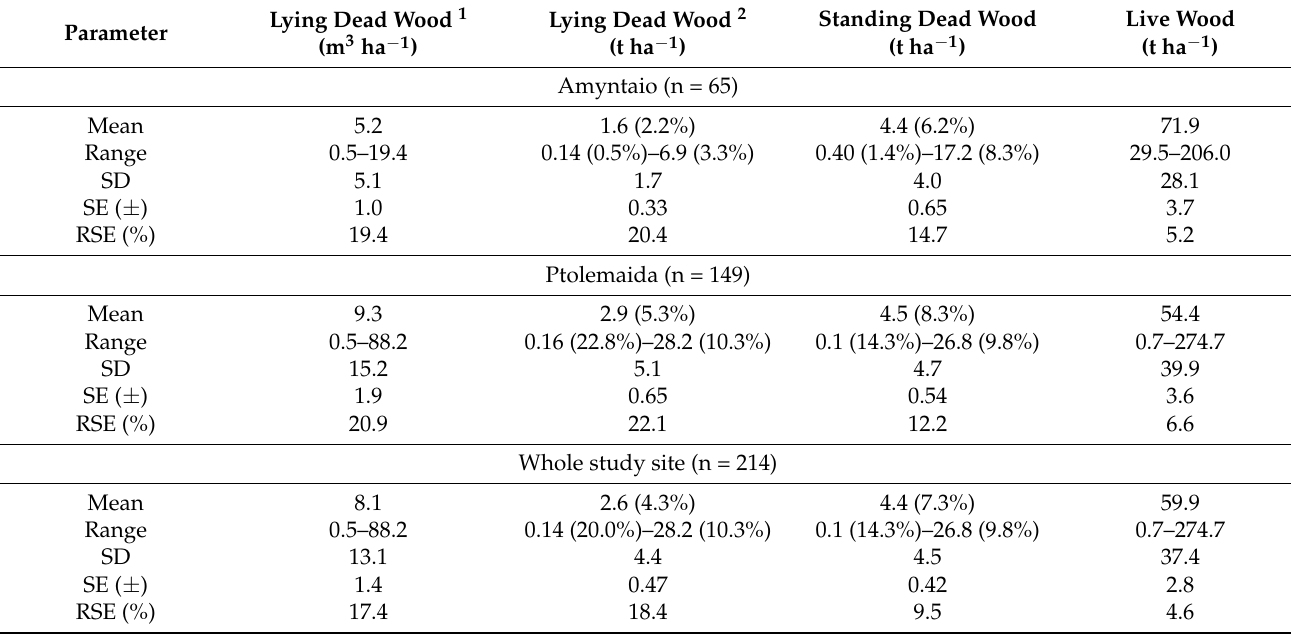
Table 3. Standing and lying black locust dead wood data at the study